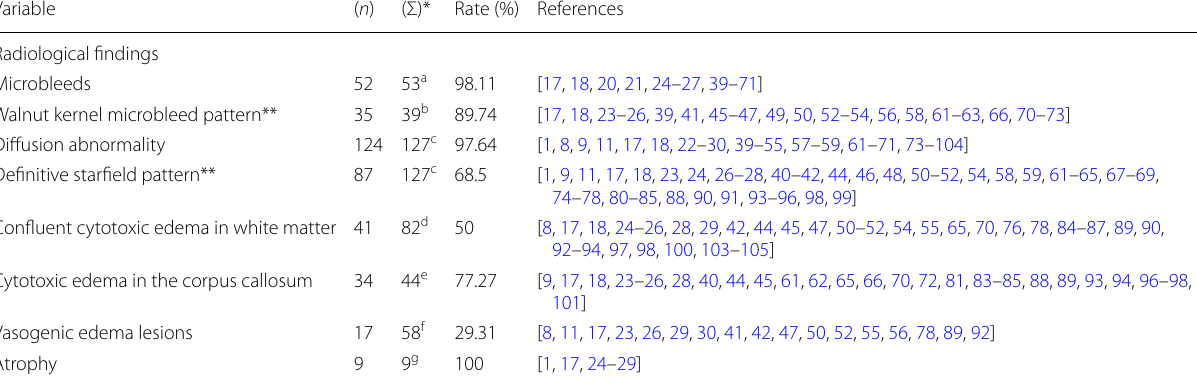
Table 3 Radiological